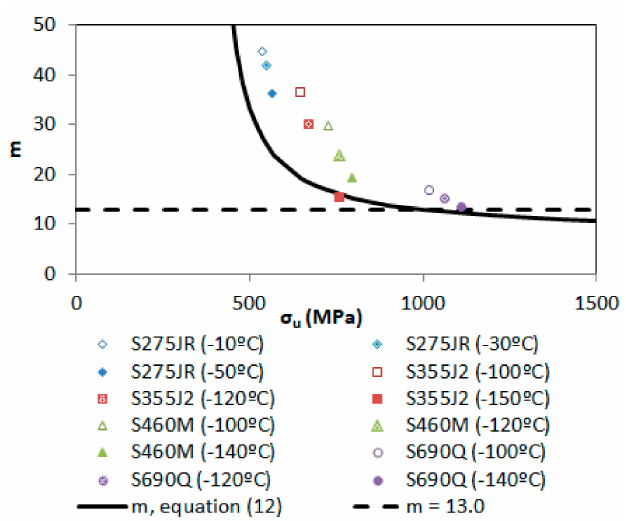
Figure 3. m values versus tensile strength for structural steels operating at the Ductile-to-Brittle Transition Zone. Derivation of a safe estimation ( m =